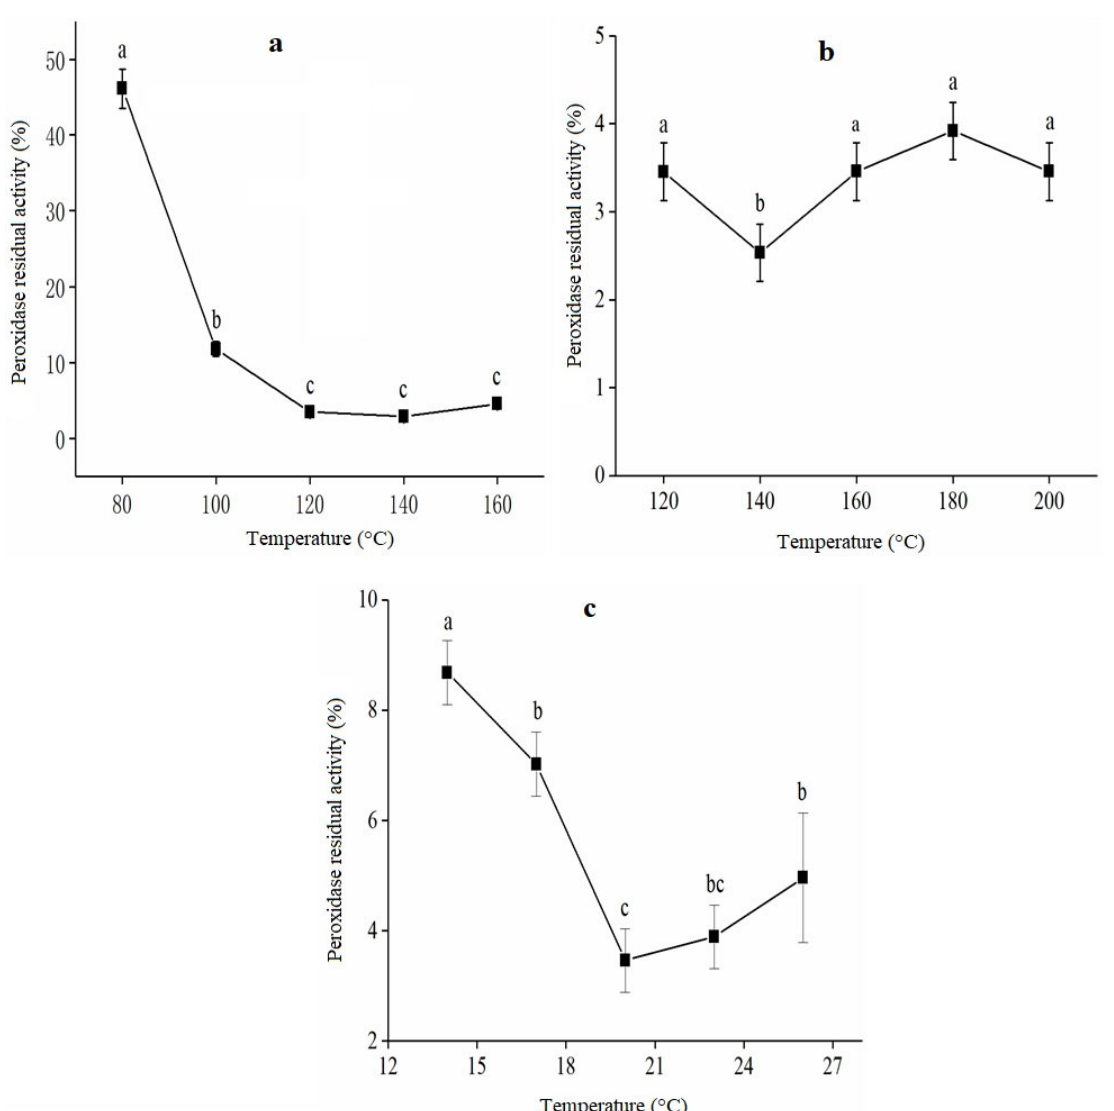
Figure 1. Effect of barrel temperature ( a ), screw speed material ( b ), and moisture content ( c ) on residual activity of peroxidase in extruded rice bran during storage. The letters in the figure indicate significant differences between different treatment times and storage conditions, with a significance level of p < 0.05.